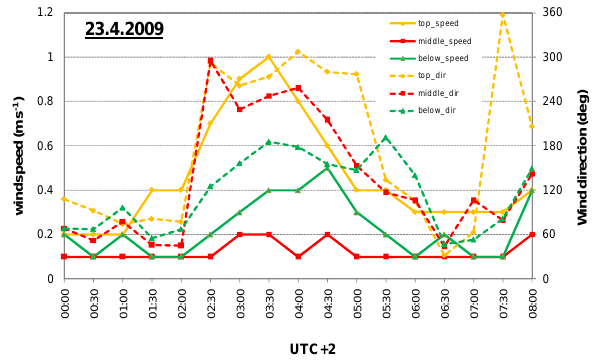
Figure 2b. Time series of wind speed (ms − 1 , solid lines) and wind direction (degrees, dashed lines) on 23 April 2009, at the three lev- els of the tower.